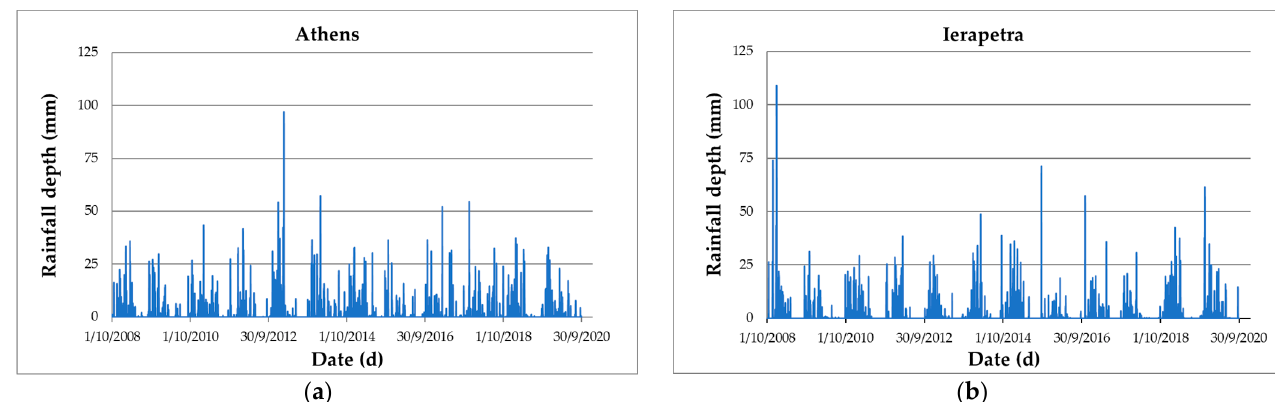
Figure 3. Distribution of daily rainfall depth for the period 2008–2020 at the station: ( a ) Athens (Attica, Greece); ( b ) Ierapetra (Crete, Greece).